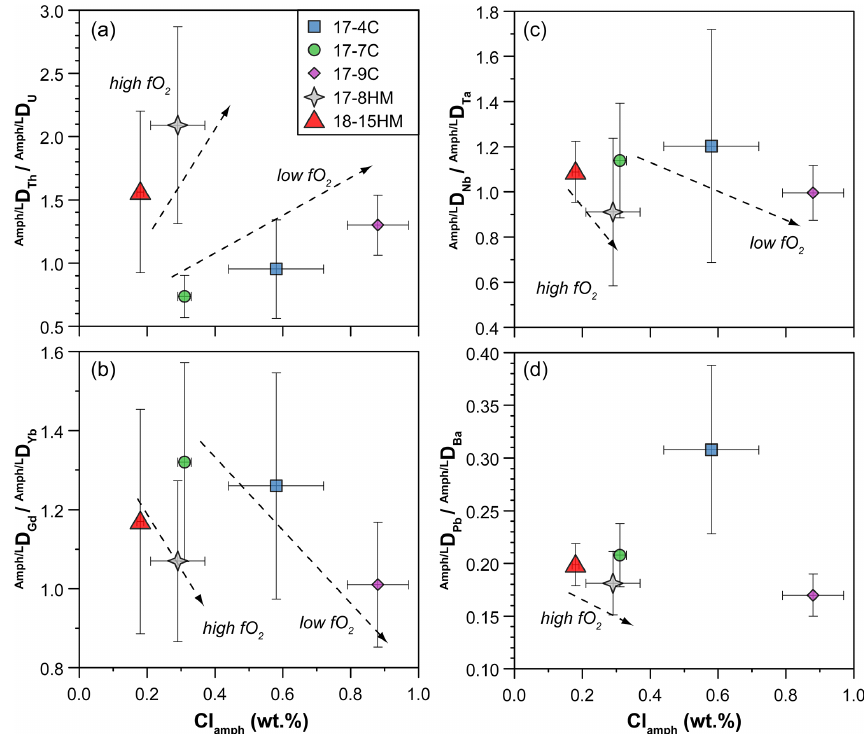
Figure 11. Chlorine content (wt%) in amphibole vs. Amph / L D Th / Amph / L D U (a) , Amph / L D Gd / Amph / L D Yb (b) , Amph / L D Nb / Amph / L D Ta (c) , and Amph / L D Pb / Amph / L D Ba (d) ratios measured in the experiments. See text for